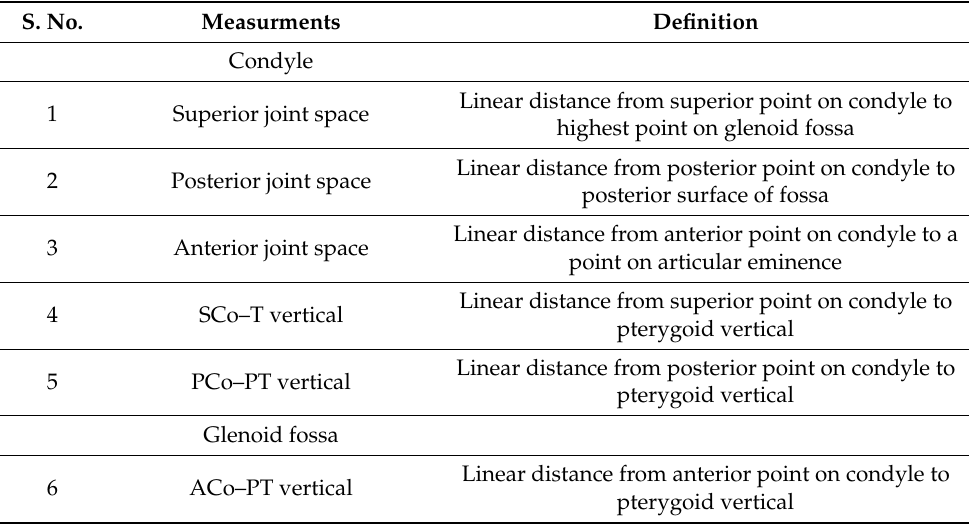
Table 3. Measurements used for evaluation of condyle-glenoid fossa changes.